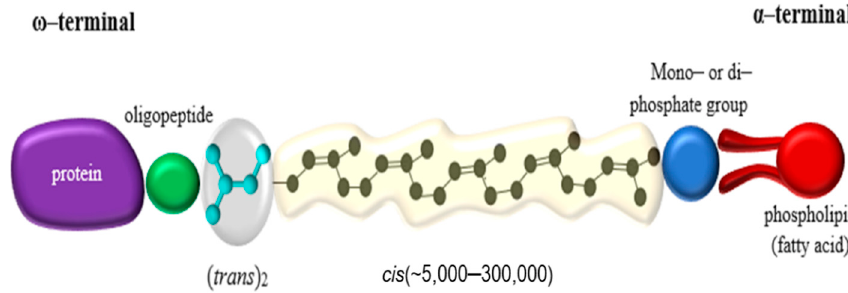
Figure 1. NR Polymer Chain.